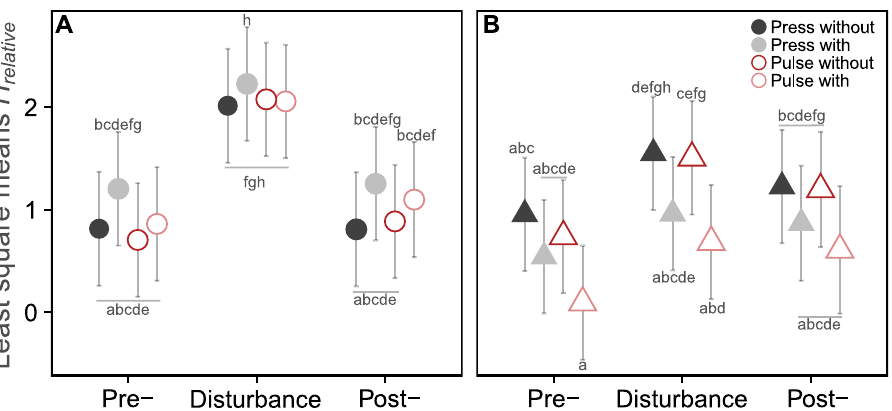
Differences in the individual means of each treatment from the mean over all treatments for all the linear mixed effect models are shown in Supplementary Figs S4–6 The results were qualitatively the same when we randomly coupled a control replicate with the treatment replicate for calculating the relative abundances/prey diversity and used the full dataset in analyses (no removal of extreme data points), see Supplementary Table S2–4 Effect of predation and abiotic disturbances on overall prey community composition.